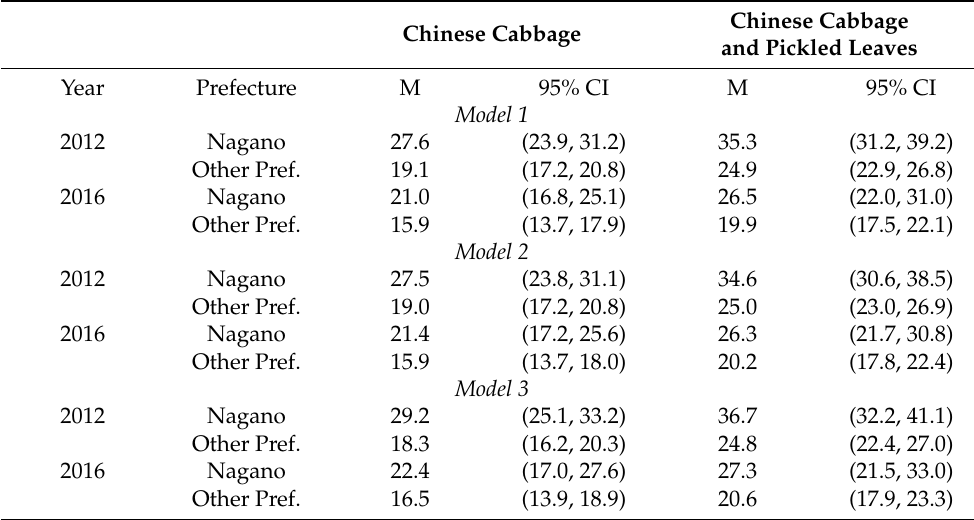
Table A3. Trends of Chinese cabbage intake according to